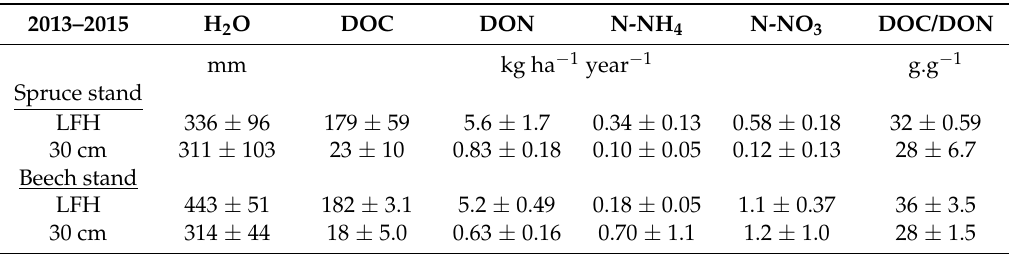
Table 5. Fluxes ( ± standard deviation) of water (mm), DOC, N (kg · ha − 1 · year − 1 ) and mass ratio